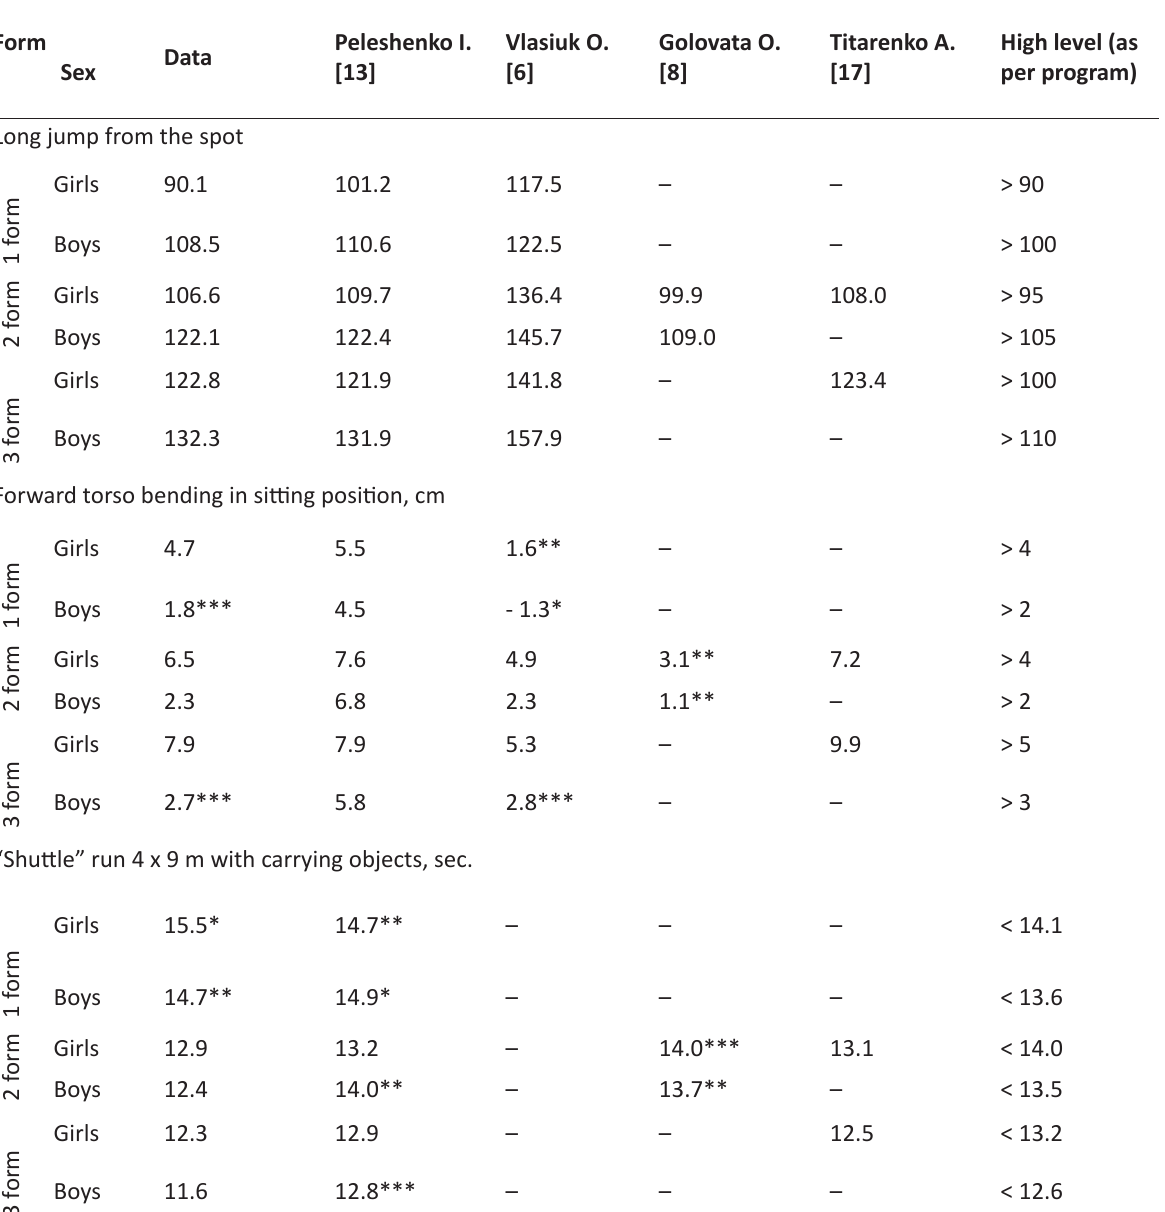
Table 2. Comparison of physical fitness mean indicators of 1 st – 3 rd forms pupils according to school norms